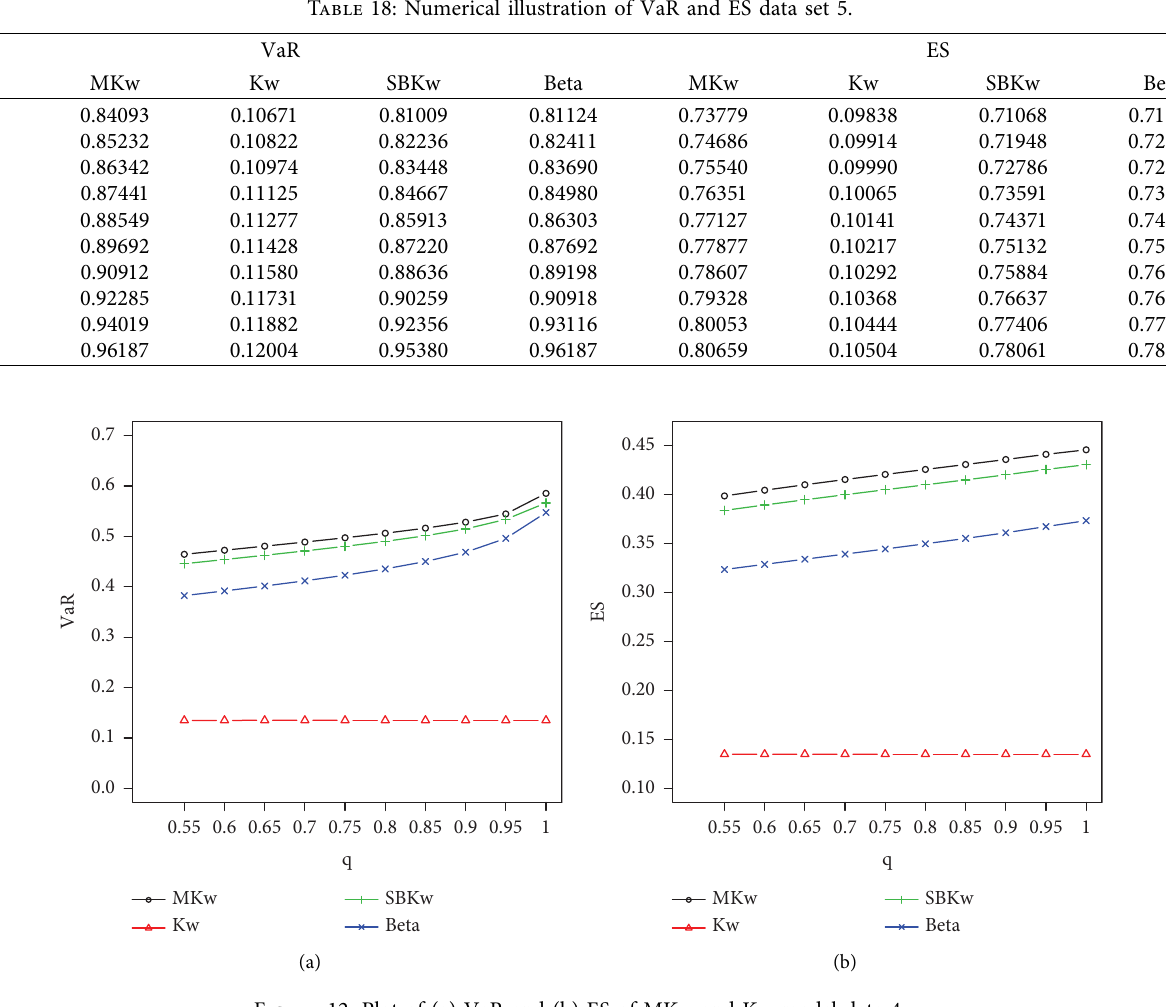
Figure 12: Plot of (a) VaR and (b) ES of MKw and Kw model data